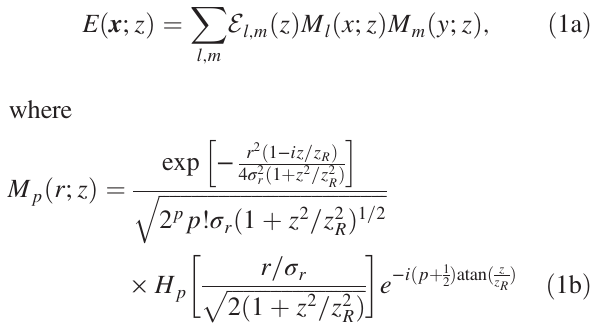
FIG. 1. Schematic of an x-ray free electron laser oscillator. The figure is not drawn to